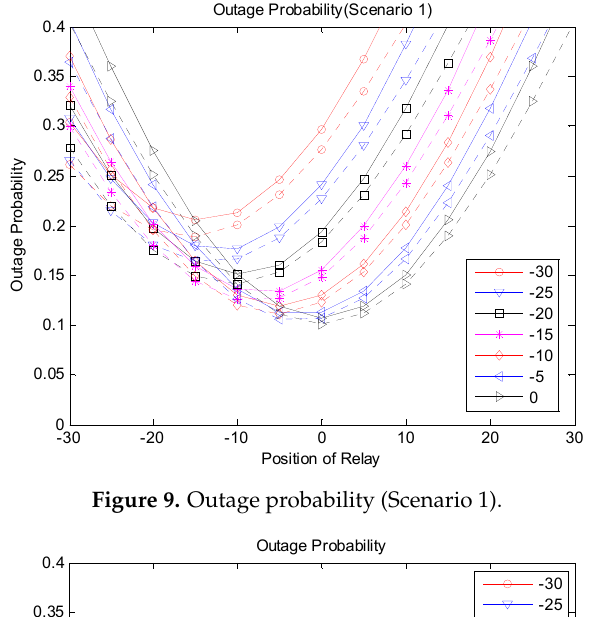
Figure 9. Outage probability (Scenario 1).